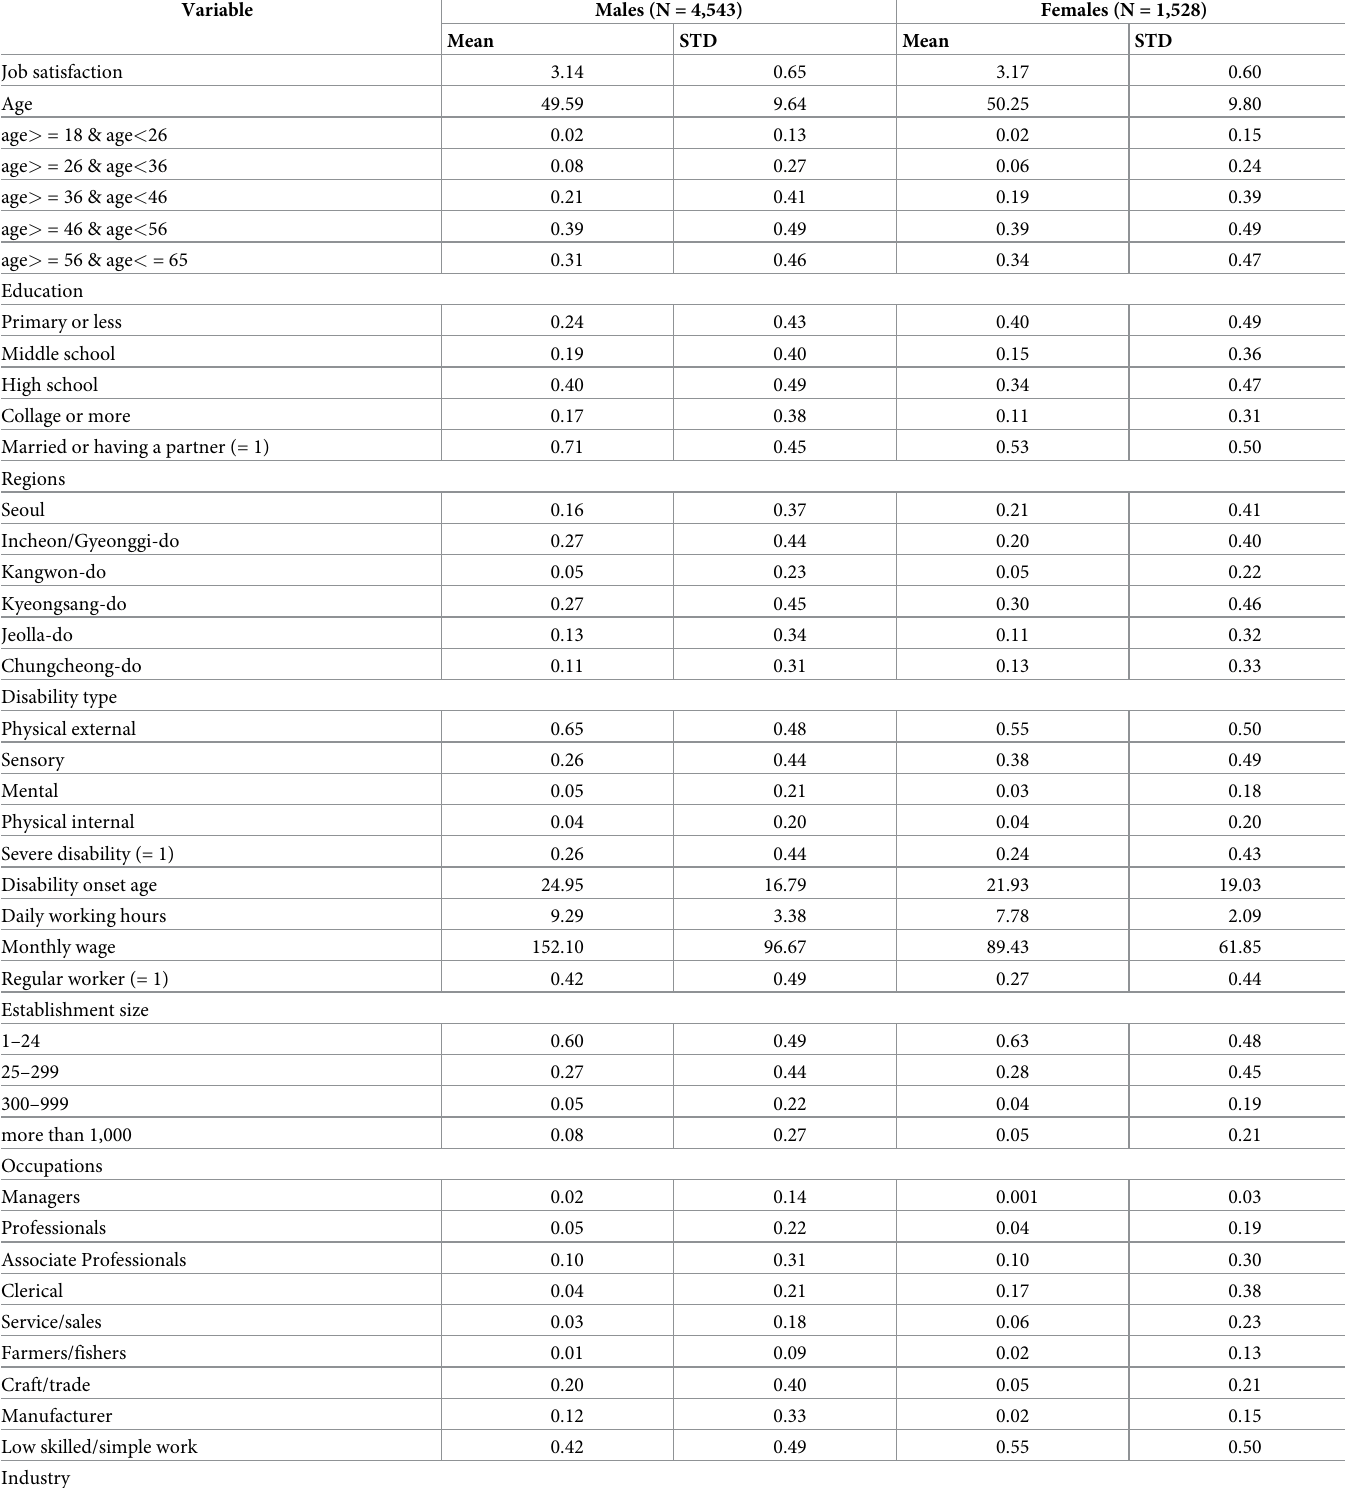
Table 1. Summary